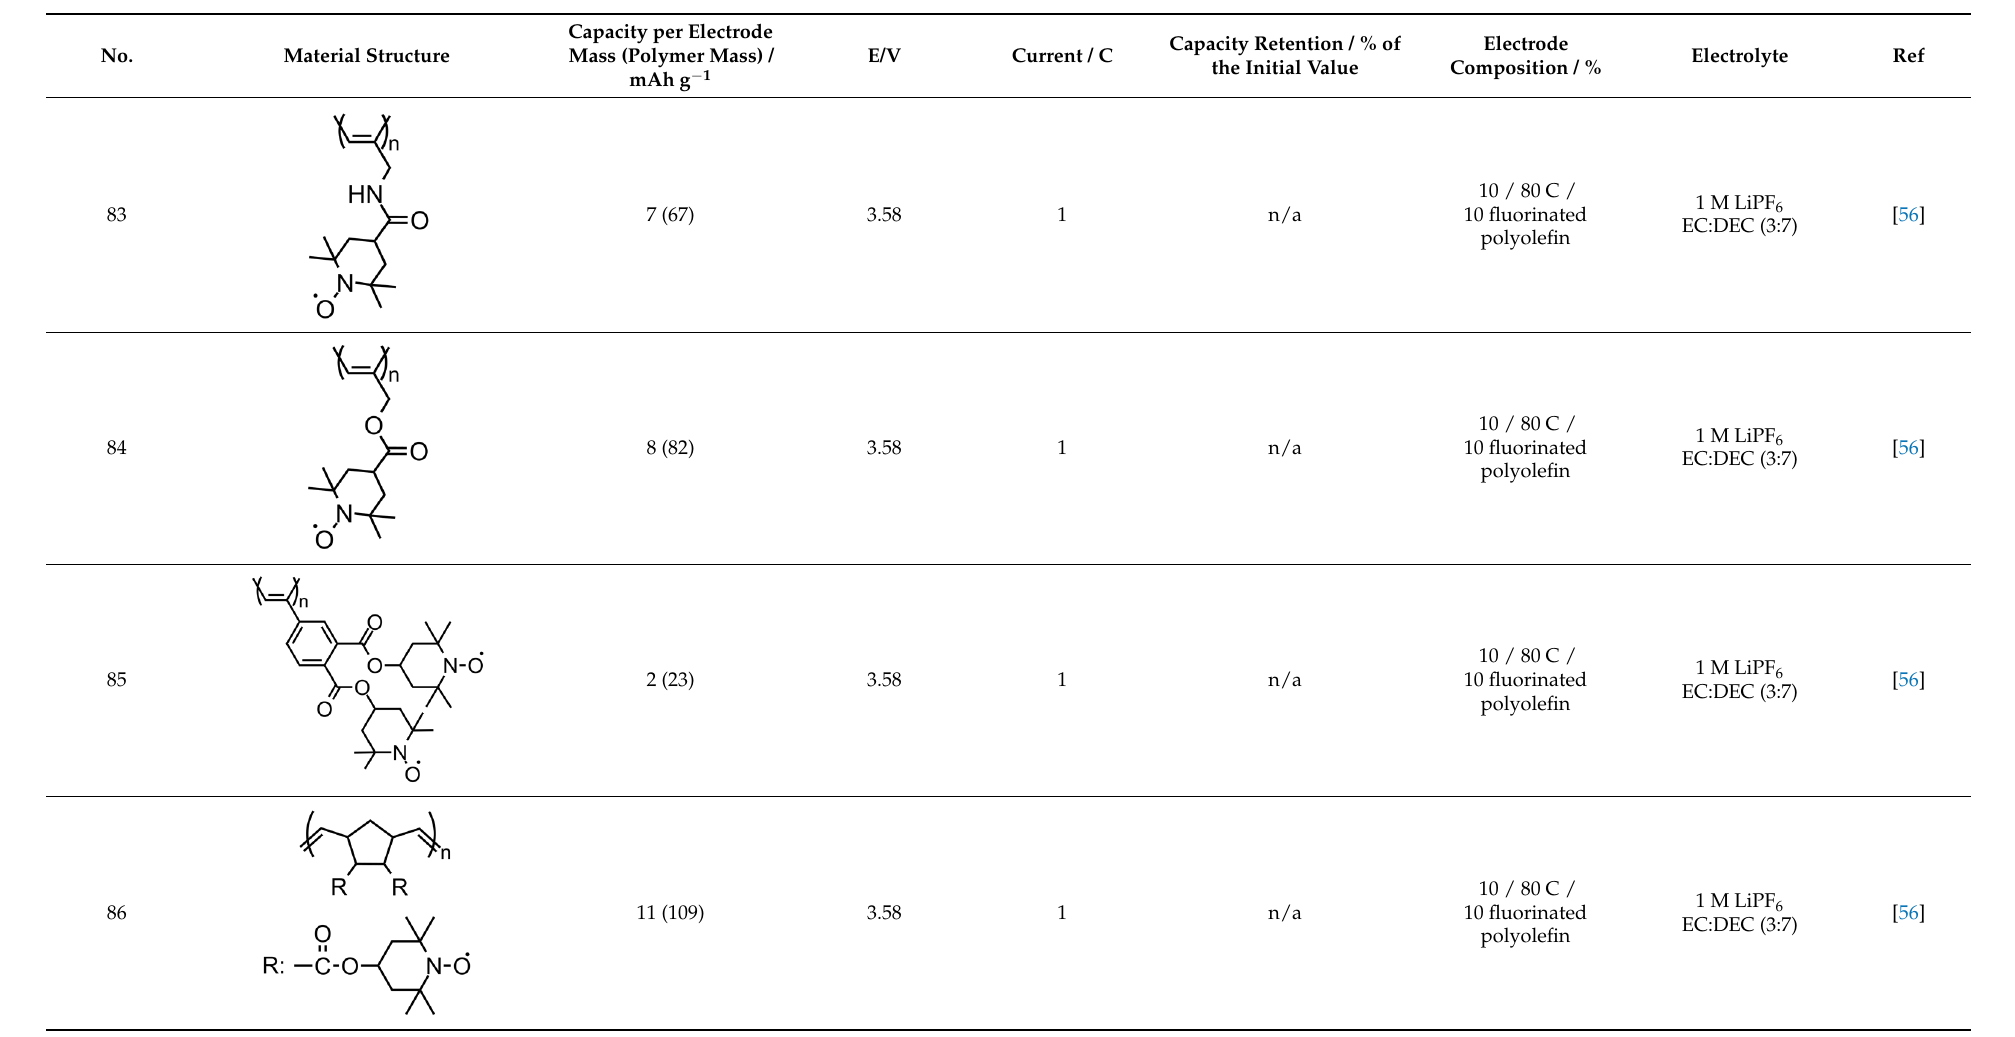
Table 2. Structures and energy storage performance of the TEMPO-containing polymers with conductive